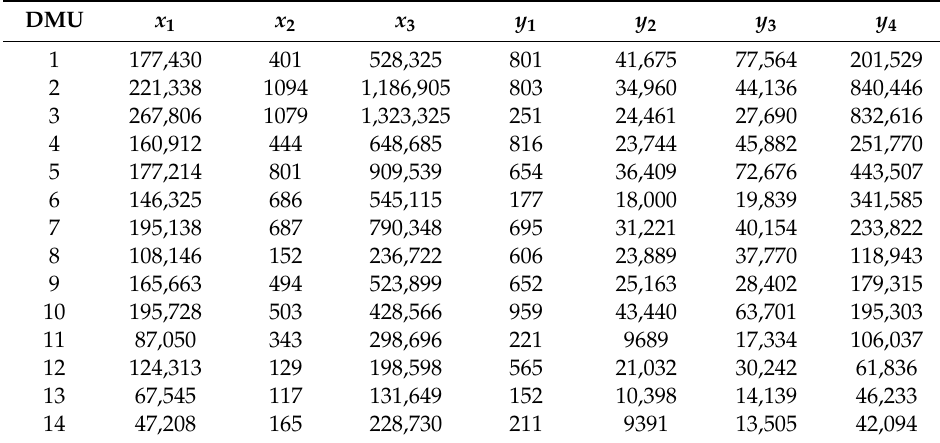
Table 2. The Iranian gas company dataset.